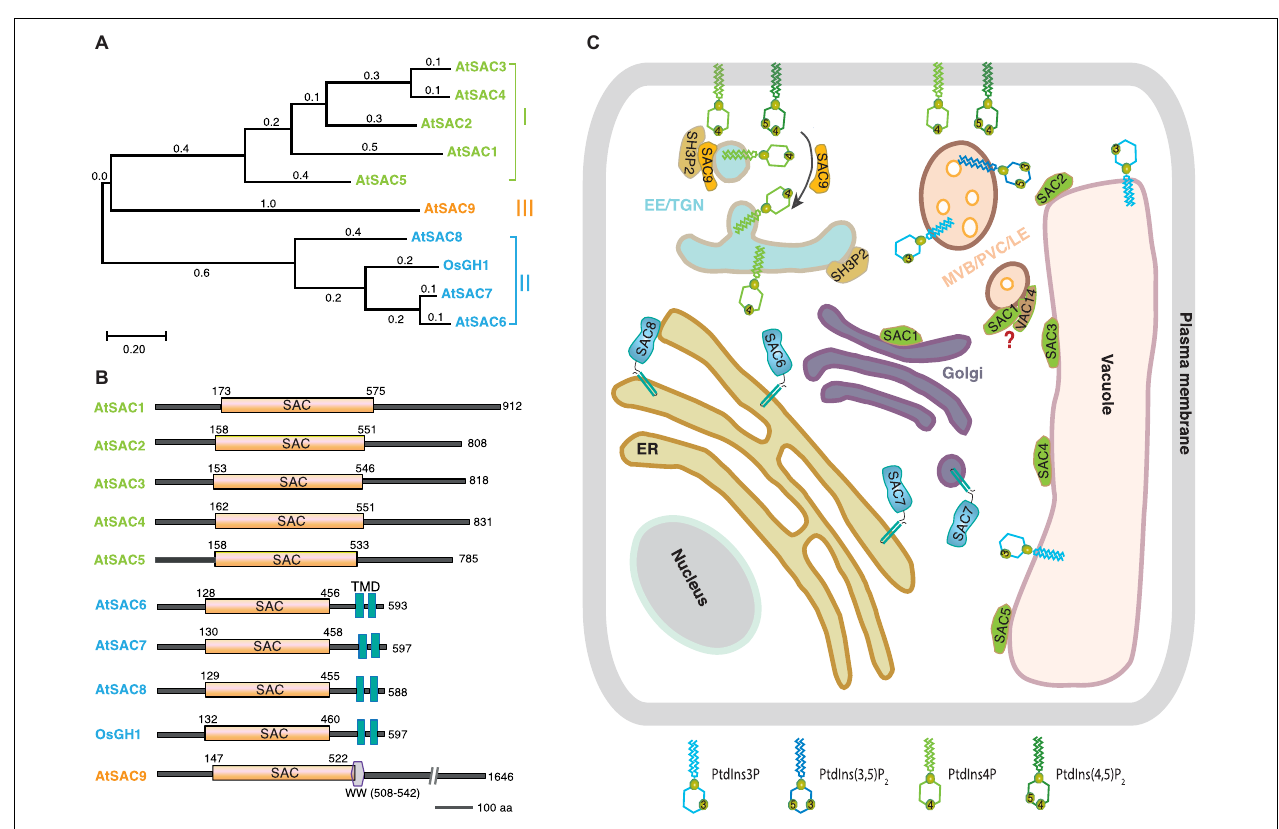
FIGURE 1 | The current overview of plant SACs. (A) Phylogenetic analysis and (B) schematic domain structures of the experimentally characterized plant SACs. The phylogenetic tree was conducted by MEGA X10.2.4 with a maximum likelihood method and a Poisson correction model. The aligned protein sequences were based on 10 plant SAC members, AtSAC1 (At1g22620.1), AtSAC2 (At3g14205.1), AtSAC3 (At3g43220.1), AtSAC4 (At5g20840.1), AtSAC5 (At1g17340.1), AtSAC6 (At5g66020.1), AtSAC7 (At3g51460.1), AtSAC8 (At3G51830.1), AtSAC9 (At3g59770.3), and OsGH1 (Os02g0554300). Domain structures were determined by using the PROSITE program (https://prosite.expasy.org/). Abbreviations, SAC, suppressor of actin domain; TMD, transmembrane domain; WW, a domain with two conserved tryptophan residues. The numbers denote the amino acid residue positions. (C) Schematic representation of sub-cellular distribution of SACs and